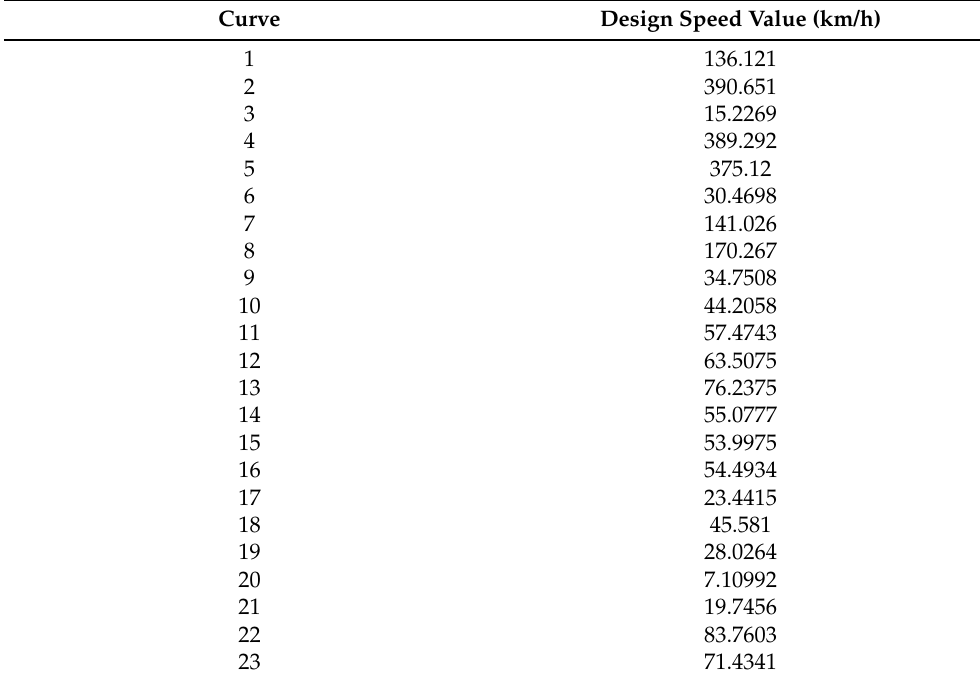
Table A8. Design Speed